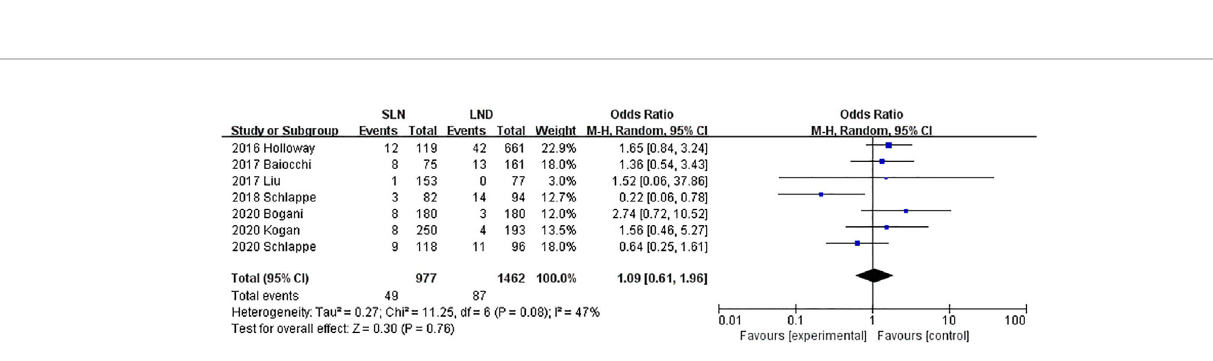
FIGURE 6 | TSA of pelvic lymph nodes, a = 0.05, b = 0.8, relative risk reduction = − 73.8%, incidence in control group = 16.4%, two-sided